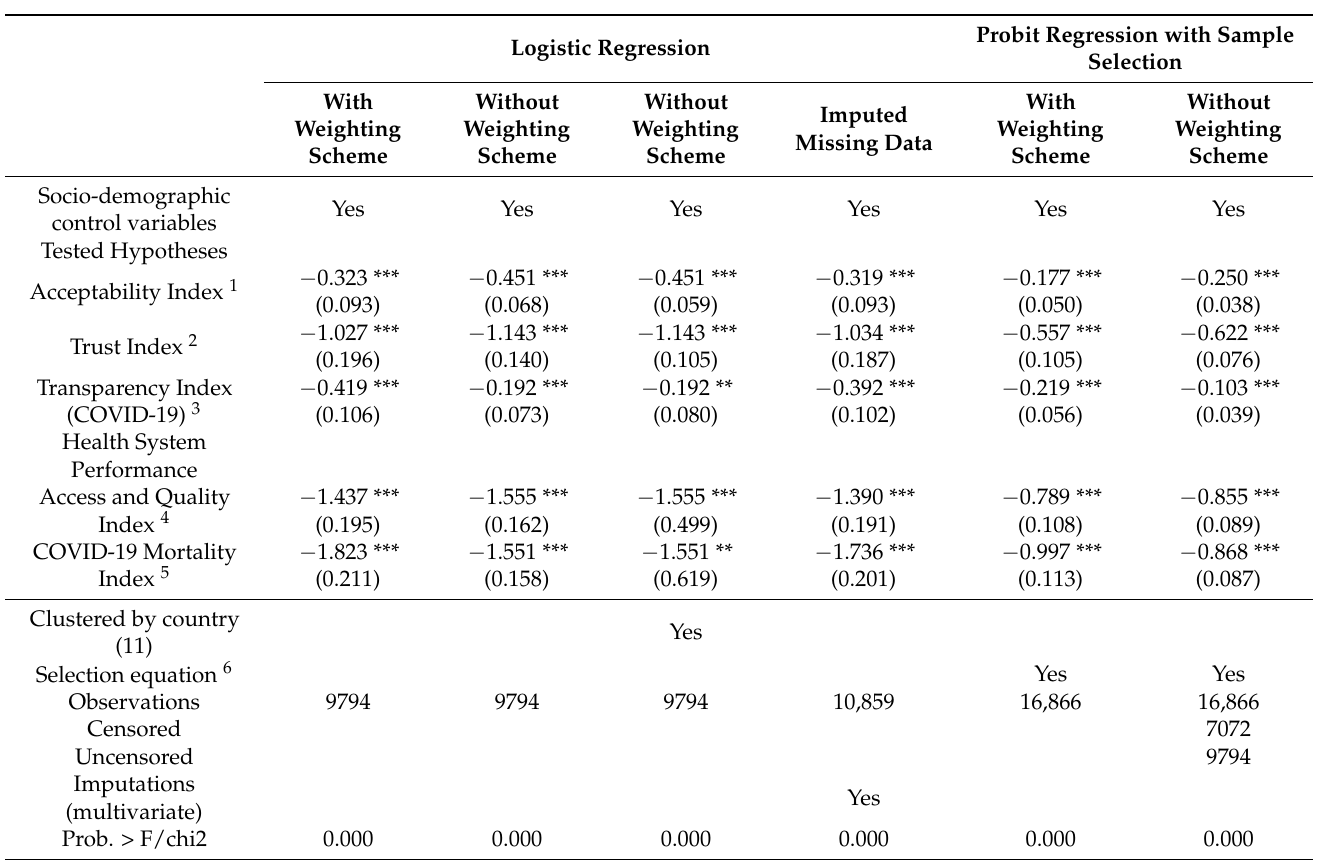
Table 5. Sensitivity analysis.